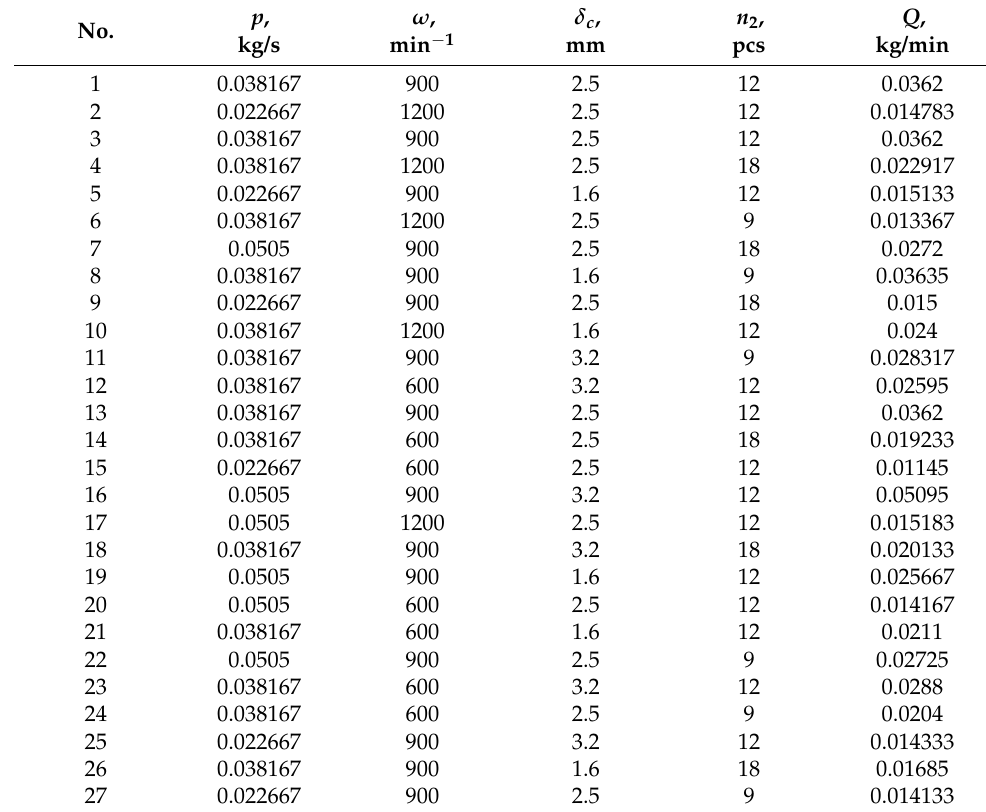
Table 1. Variable values of parameters and productivity of the centrifugal-rotary feed grain shredder.